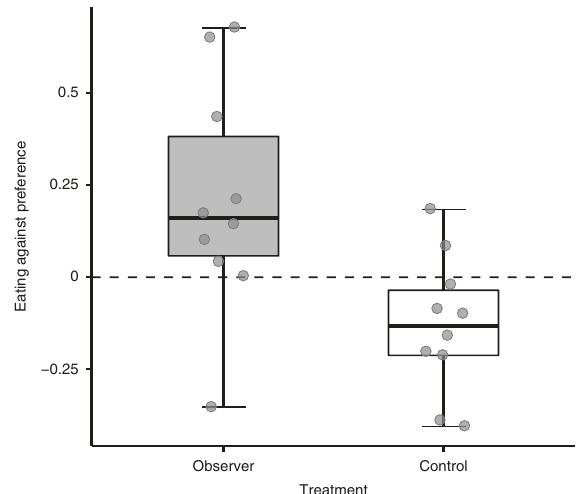
Fig. 2 Socially learned adjustment of a cooperative foraging decision. The effects of social observation on the extent to which juvenile cleaners ate against preference in the test phase of experiment 1. Dashed line marks the juveniles' predicted score based on their initial feeding preferences. Values above and below 0, indicate that the fi sh ate more and less fl ake items, respectively, than predicted according to their baseline food preferences. Observer treatment, in which the juveniles had witnessed the plates fl eeing in response to adults ’ consumption of preferred prawn, is marked in grey ( N = 10). Control treatment, in which the adults could not interact with the plates, is marked in white ( N = 10). Boxplots show the median and interquartile range, whiskers denote 1.5 × interquartile range and dots mark individual data points. Source data are provided as a Source Data fi le.